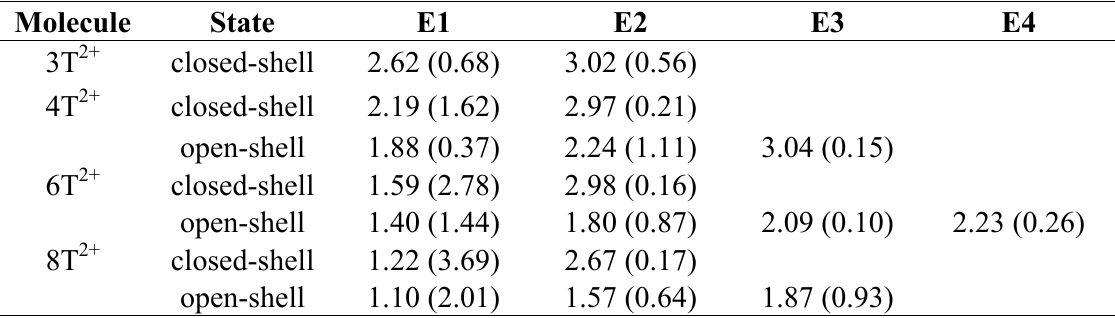
Table 1. Excitation energy in eV of closed-shell 3T 2+ , 4T 2+ , 6T 2+ and 8T 2+ and